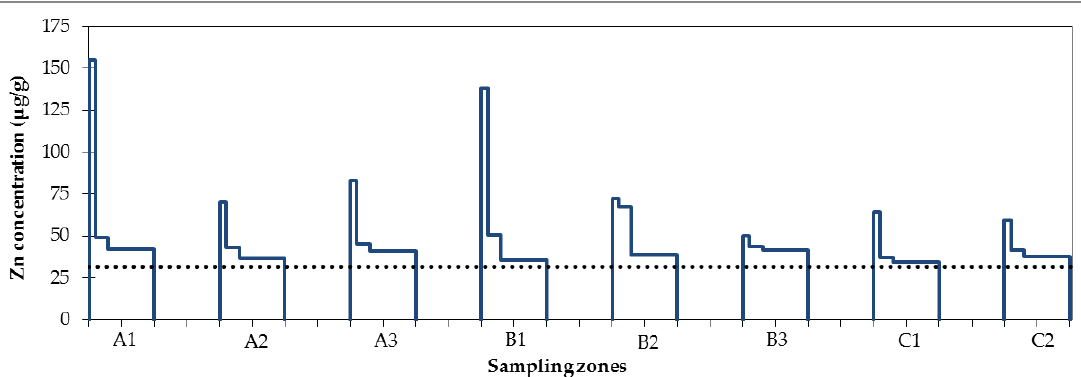
Figure D1. Concentrations of calcium measured in composite cores of each sampling zone. Within each zone, concentrations from cores taken at depths of 0–5 cm, 5–15 cm and 15–50 cm are represented to scale from left to right. The dotted line represents the concentration measured in the initial soil sample.